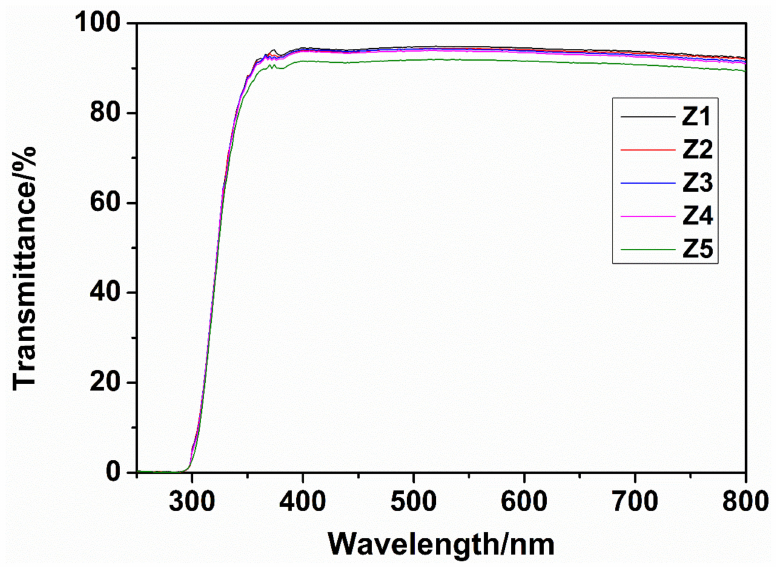
Figure 7. Transmittance curves of SiO 2 / ZrO 2 composite organic–inorganic transparent coatings with di ff erent